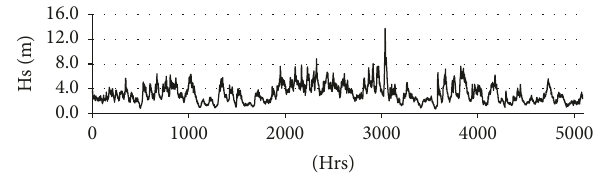
Figure 4: Plot of the September–April Hs time series of 05-06.